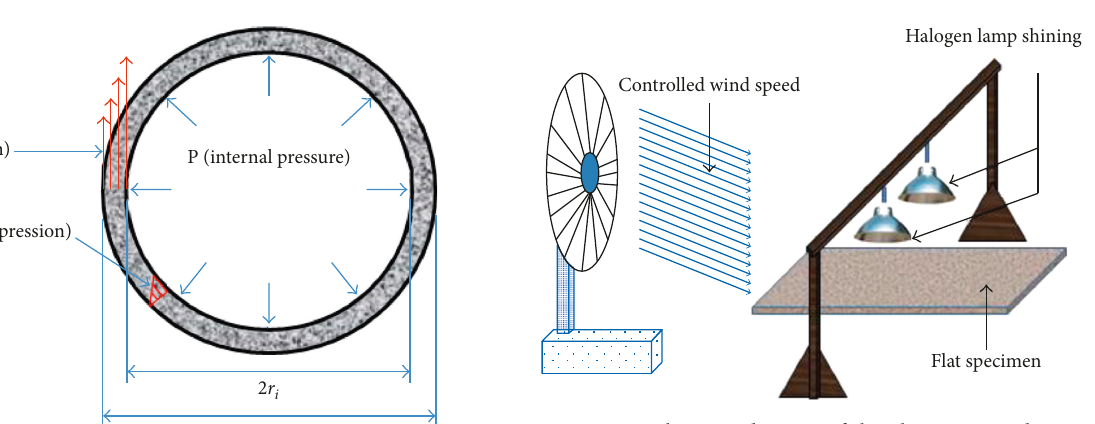
Figure 4: Schematic diagram of the plate-restrained test.